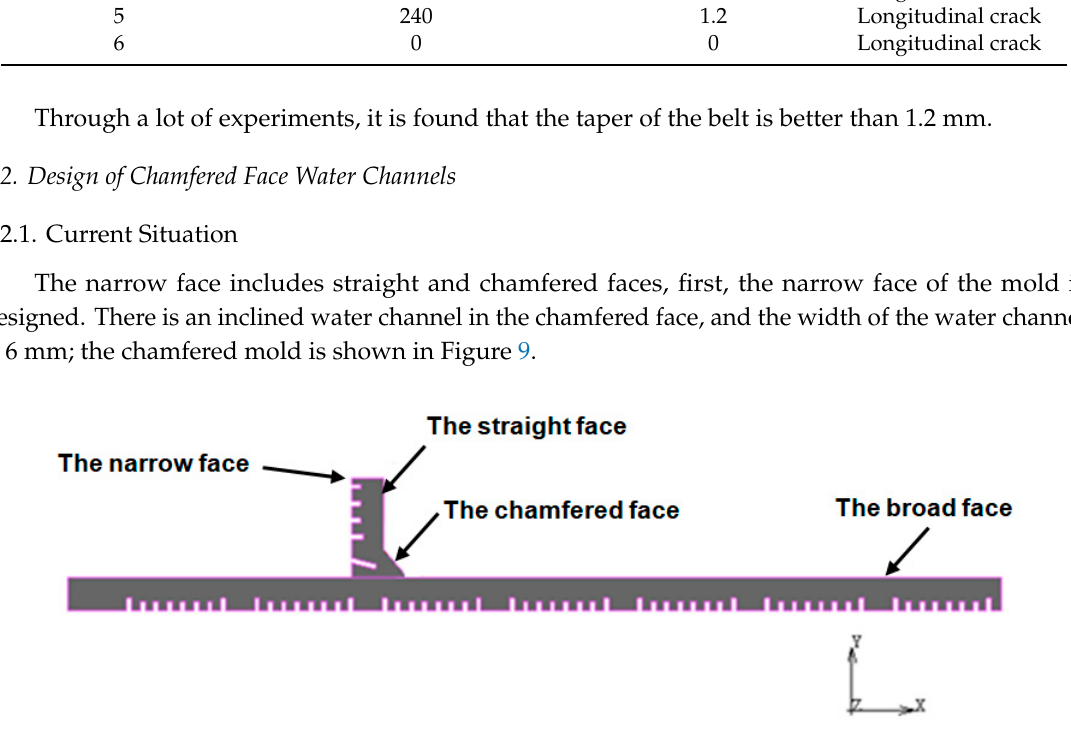
Figure 9. One quarter of the chamfered mold.